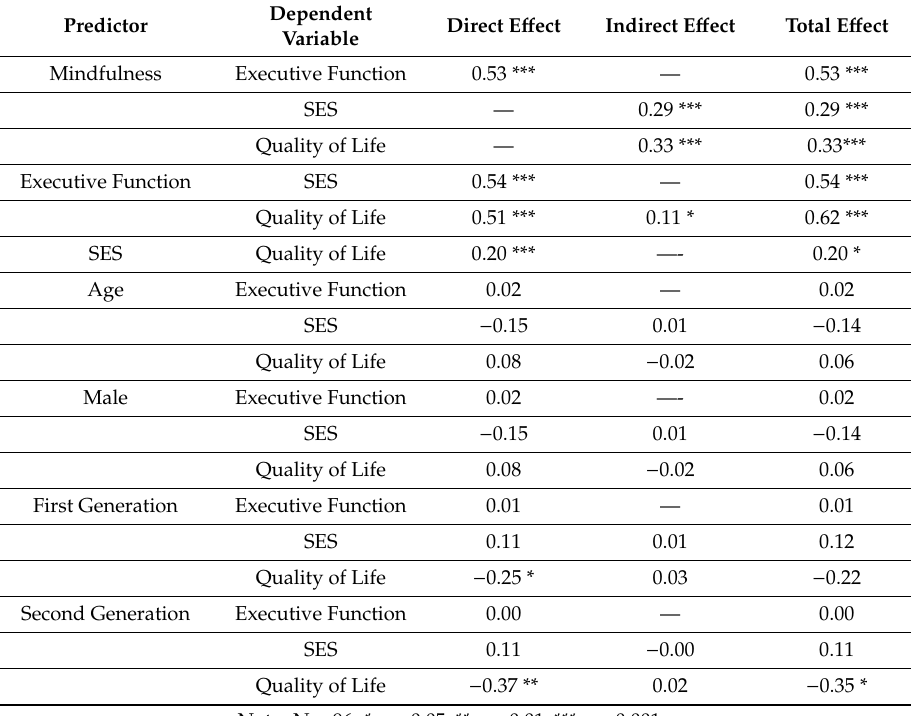
Table 3. Decomposition of Standardized E ff ects in SEM.